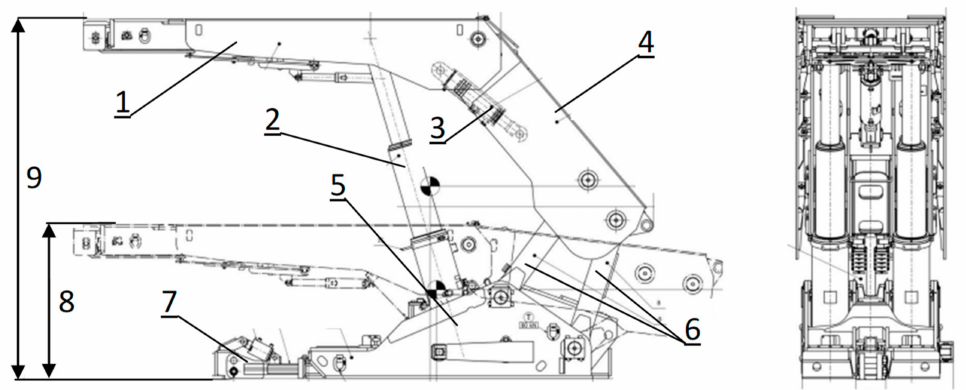
Figure 2. Powered roof support, where 1—canopy, 2—hydraulic prop, 3—canopy support, 4—the shield support, 5—floor base, 6—lemniscate mechanism, 7—shifting system, 8—minimum expansion height, and 9—maximum expansion